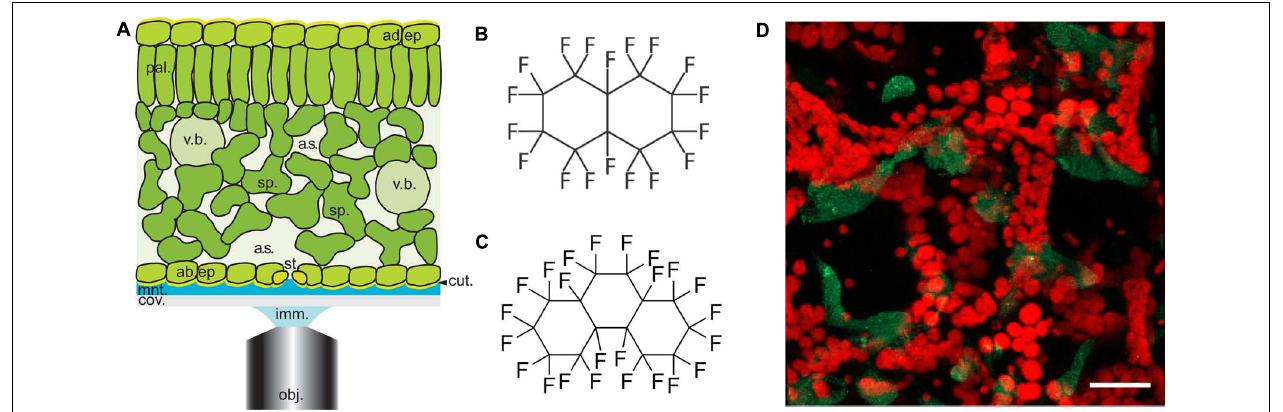
FIGURE 1 | Arabidopsis leaf anatomy, chemical structures of perfluorocarbons used in this study and a typical image of Pseudomonas infected leaves. (A) Diagrammatical representation showing the anatomical features of the Arabidopsis leaf in relation to the optical set-up. Abbreviations used are obj, objective lens; imm, immersion fluid; cov, coverslip; mnt, mountant; cut, cuticle; ad. ep, adaxial epidermis; st, stomatal pore; sp, spongy mesophyll; a.s,